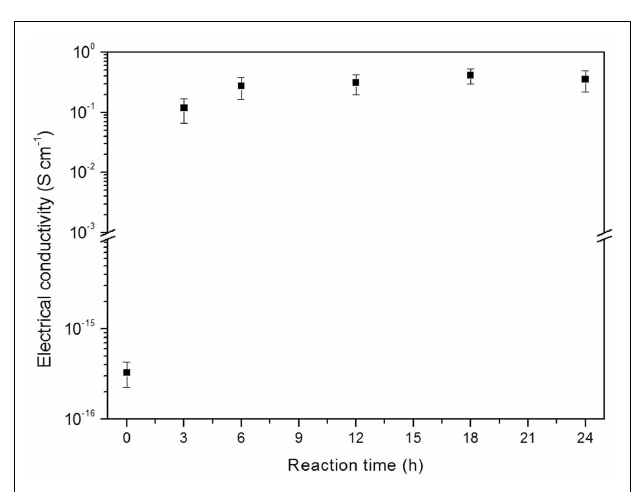
FIGURE 2 | Electrical conductivity as function of reaction time of PVDF/PANI mats obtained with aniline concentration of 0.3molL − 1